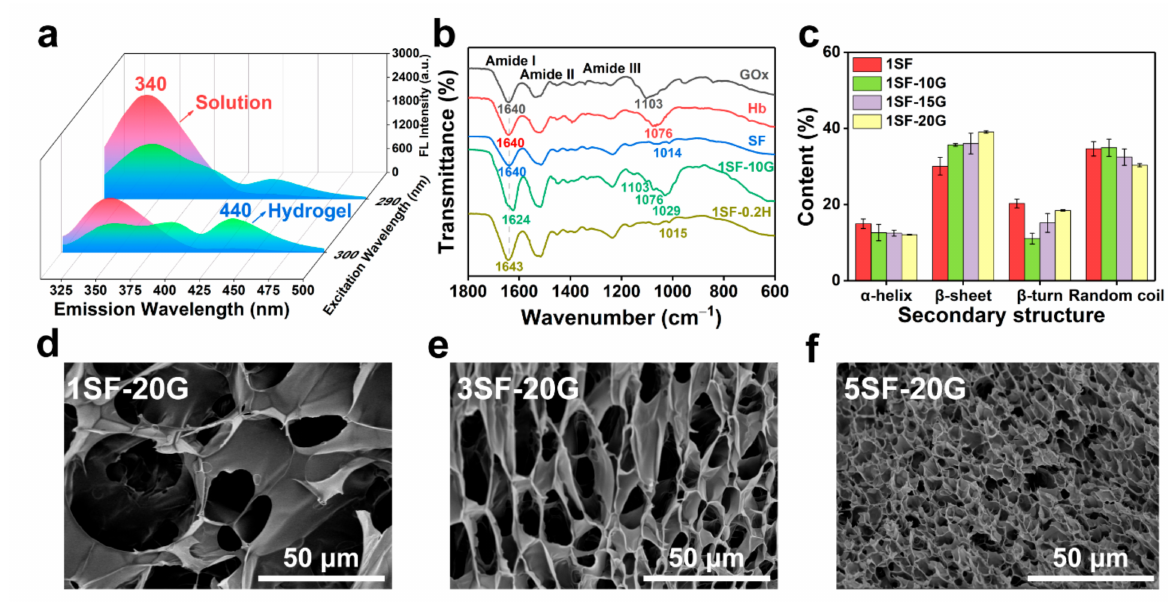
Figure 2. Mechanism of SF hydrogel formation and characterization of hydrogel morphology. ( a ) Fluorescence excitation-emission spectra of SF solution and SF/glucose/GOx/Hb hydro- gel. ( b ) FTIR spectra of GOx, Hb, SF, and 1SF-10G. ( c ) Content of second structure of SF and SF/glucose/GOx/Hb hydrogels by peak-fitting. The 3D porous structure of SF hydrogel: ( d ) 1SF- 20G, ( e ) 3SF-20G, ( f ) 5SF-20G. Error bars represent the mean ± standard deviation (s.d.); n ≥